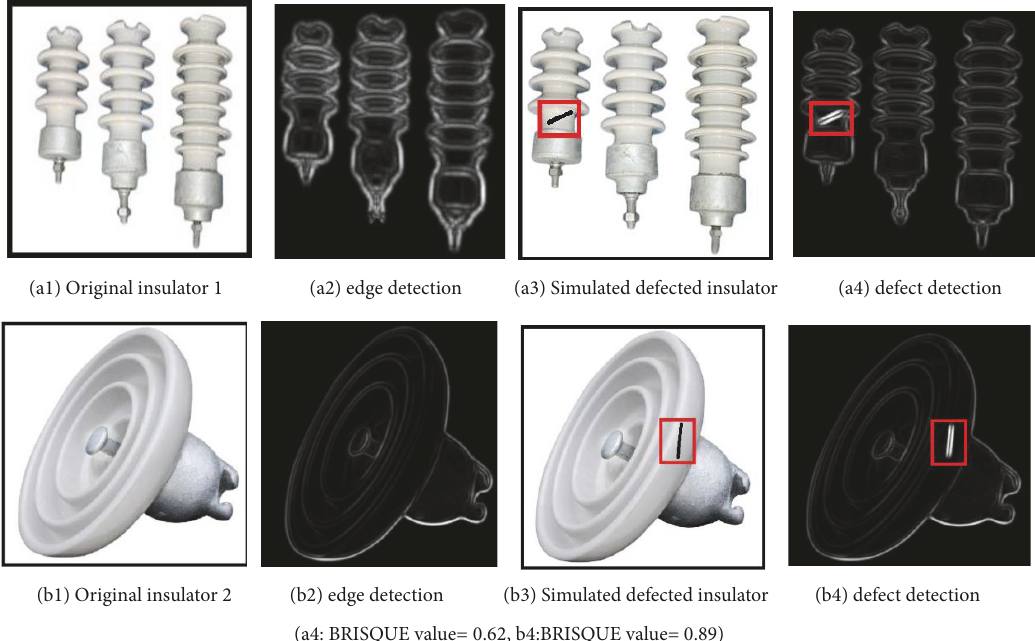
Figure 6: Simulated defected detection of ceramic electrical